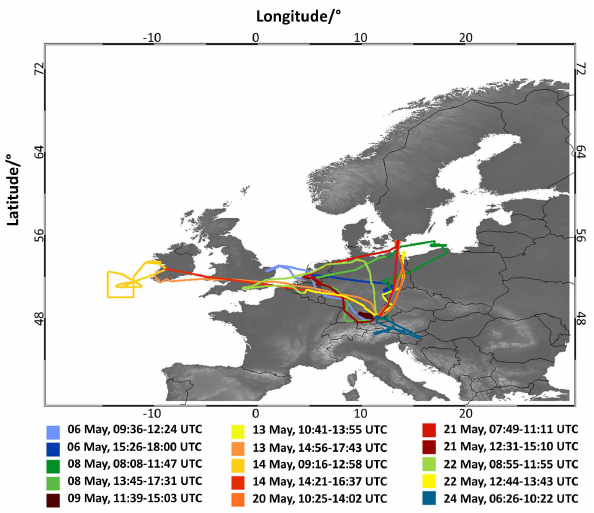
Fig. 3. Falcon flight tracks during EUCAARI-LONGREX.